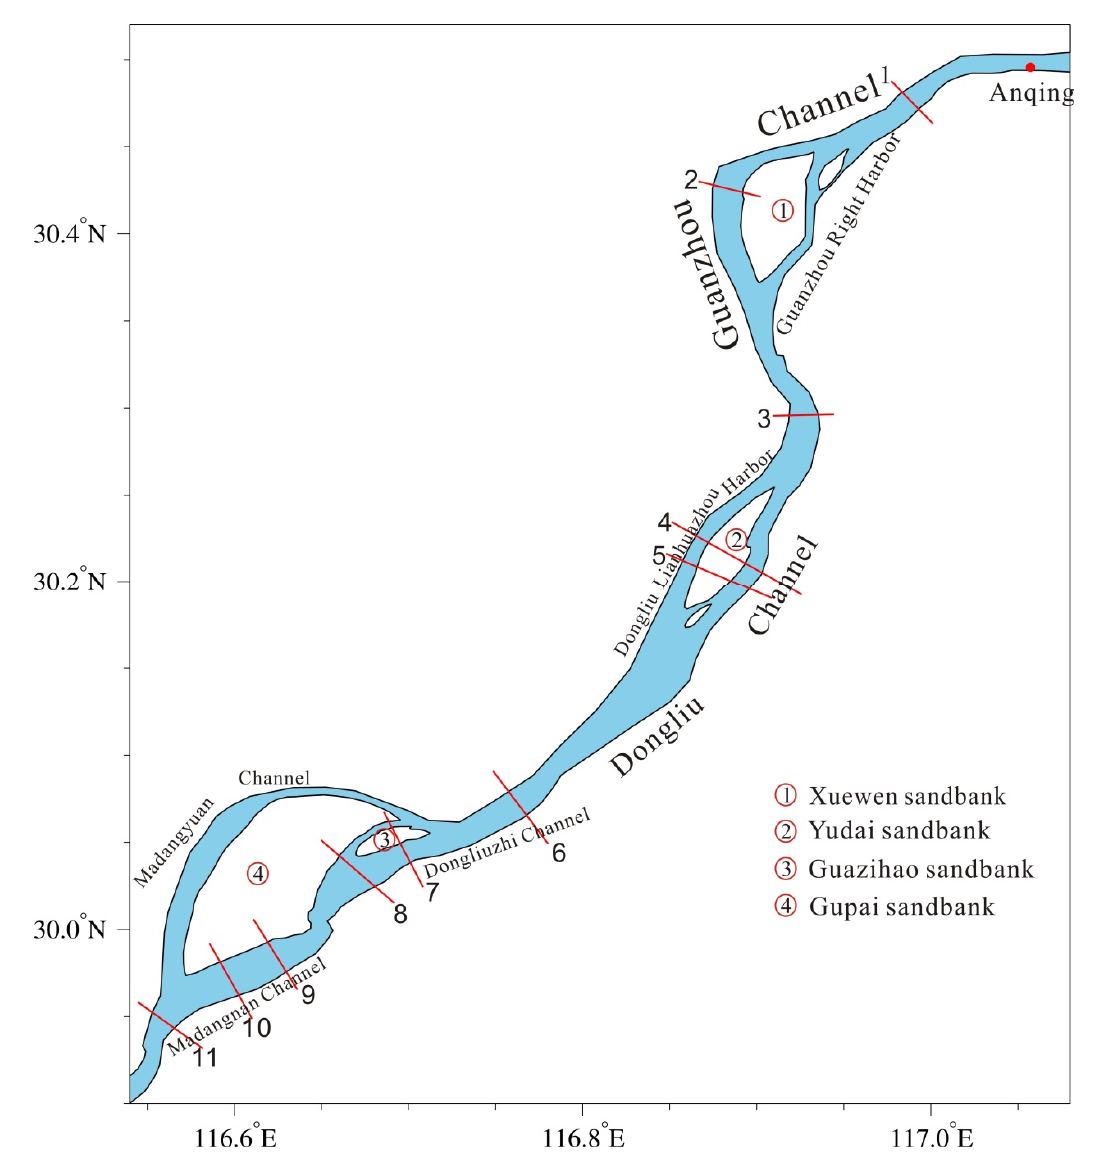
Figure 12. Tidal level limits under various guarantee rates of river discharge in the Changjiang River’s estuary in the dry season. The locations of sections 1–11 are the tidal level limits corresponding to the guarantee rates of 5–95% of river discharge.